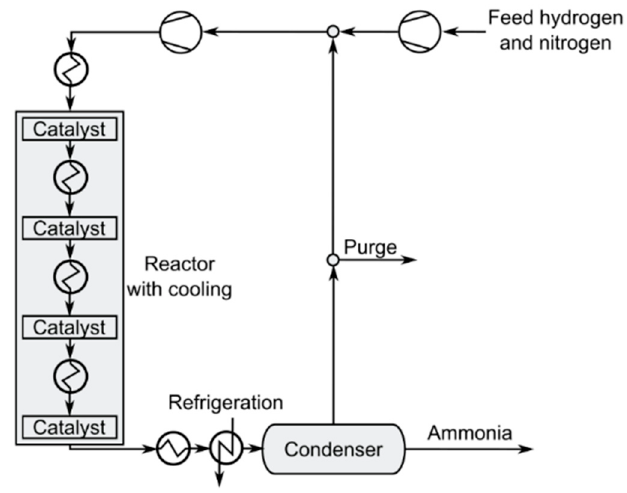
Figure 4. Generic layout of Haber-Bosch NH 3 synthesis loop.